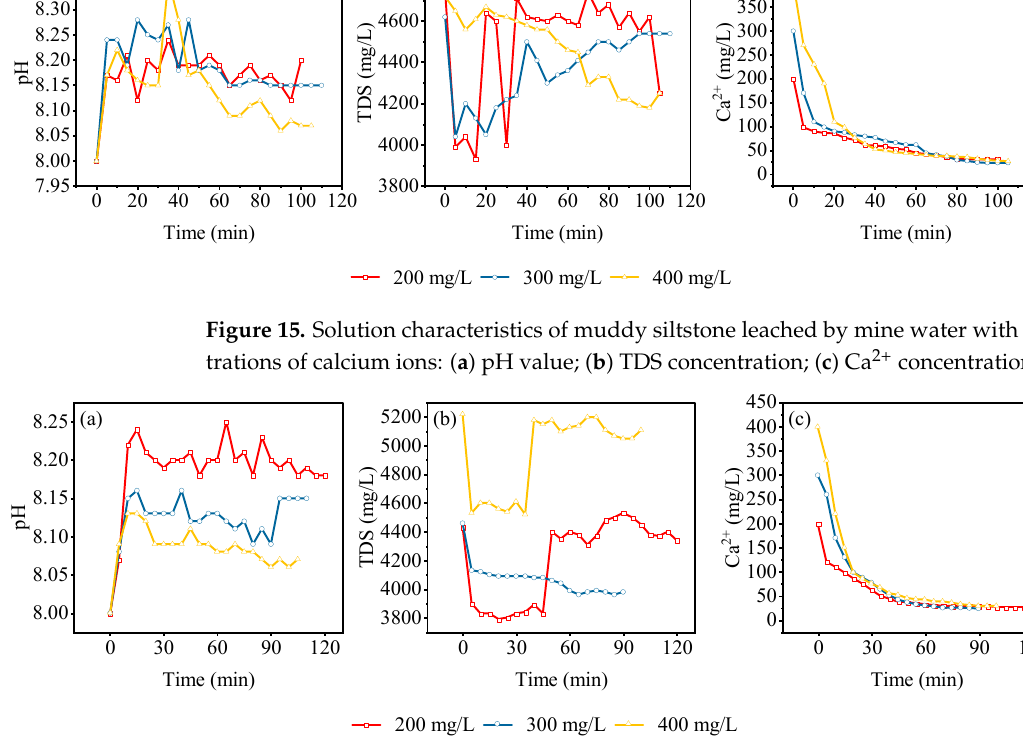
Figure 16. Solution characteristics of medium-grained coarse sandstone leached by mine water with different concentrations of calcium ions: ( a ) pH value; ( b ) TDS concentration; ( c ) Ca 2+ concentration.